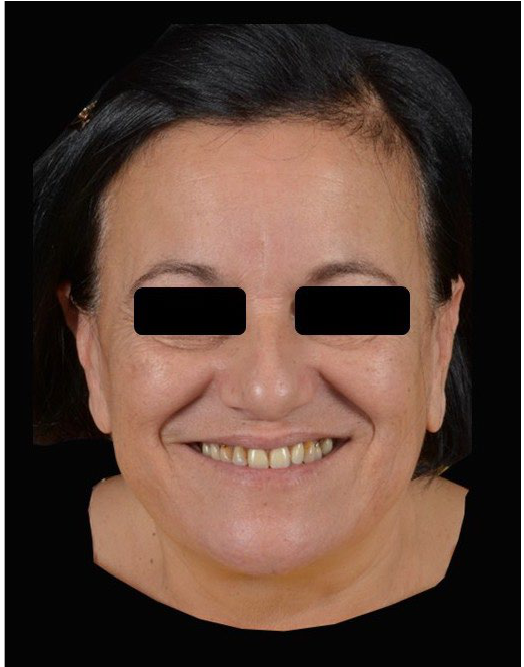
Figure 1. Extraoral aspect of the patient smile.